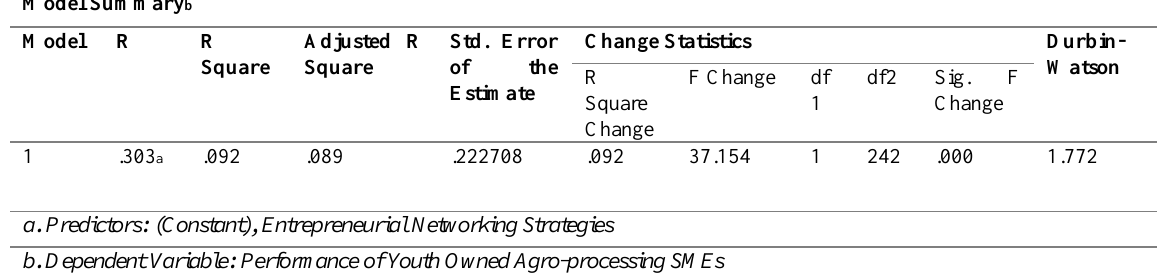
Table 2: Model Summary of Influence of Entrepreneurial Networking Strategies Renewal on Performance